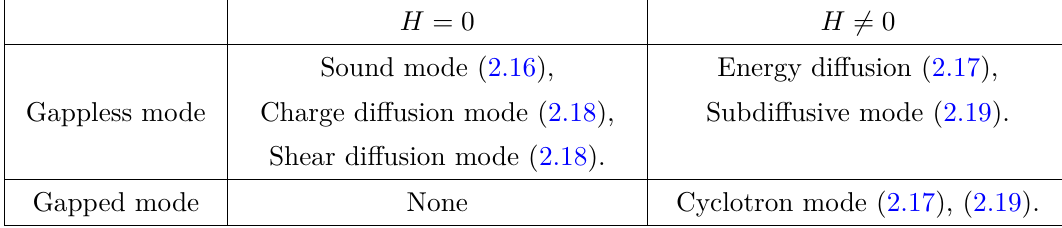
Table 1. Summary of the dispersion relations from hydrodynamics at zero